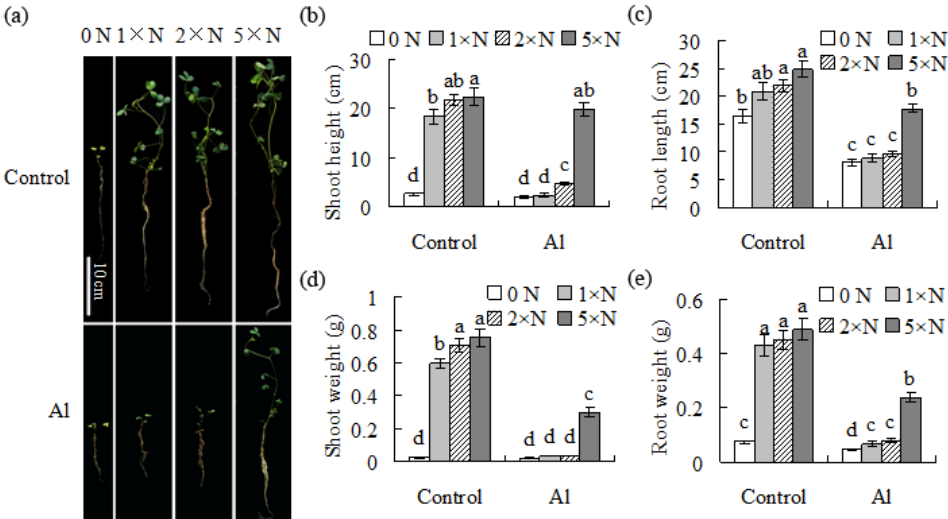
Figure 5. Analysis of the shoot and root growth, as affected by exogenous nitrogen under Al-stressed conditions. One-week-old seedlings of alfalfa were moved to a fresh nutrient solution (pH 4.3) containing 1 mM AlCl 3 or not, as a control, plus the addition of 0, 0.0267, 0.0534 or 0.1335 g/L NH 4 Cl. After four weeks, photographs were taken of the plants ( a ), followed by measurements of the shoot height ( b ), root length ( c ), shoot weight ( d ) and root weight ( e ). The data are means ± SE ( n = 30). The same letter above the column indicates no significant difference at p < 0.05.